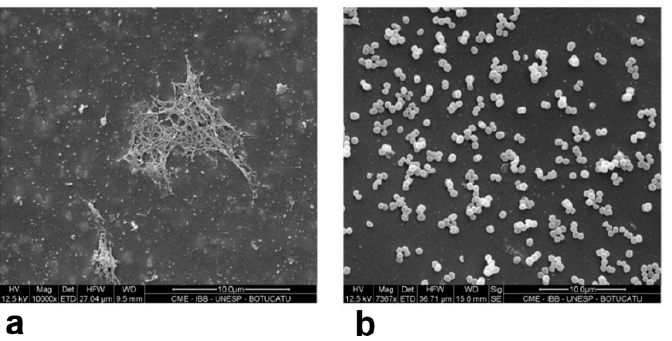
Figure 2. ( a , b ): SEM results for the positive control S. epidermidis ATCC 35983 (weakly adherent) ( a ) pure culture; ( b ) S. epidermidis ATCC 35983 isolate incubated with 200 µg/mL RIP. Scale bar ( a , b ): 10 µm.